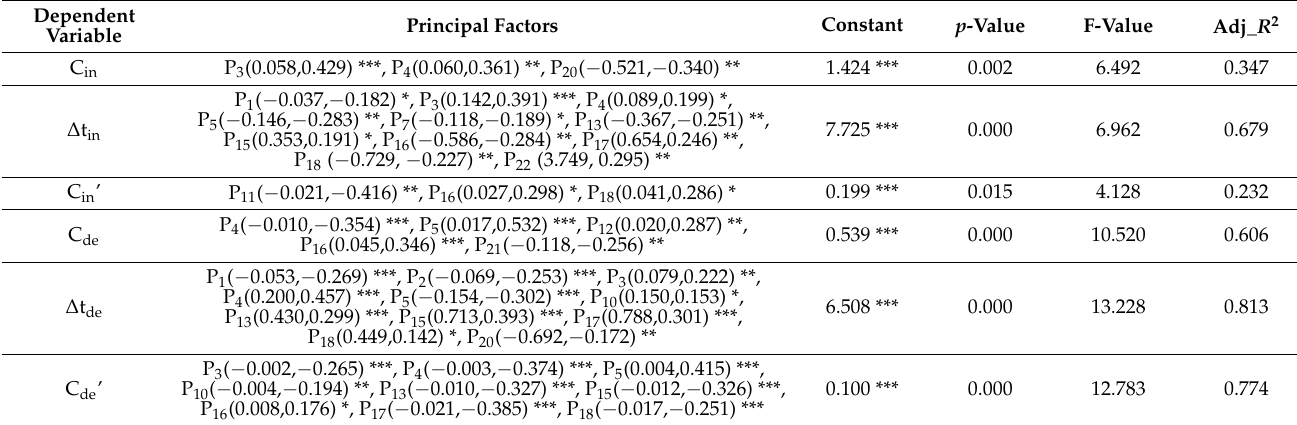
Table 2. Regression model of principal factors at the overall pollution